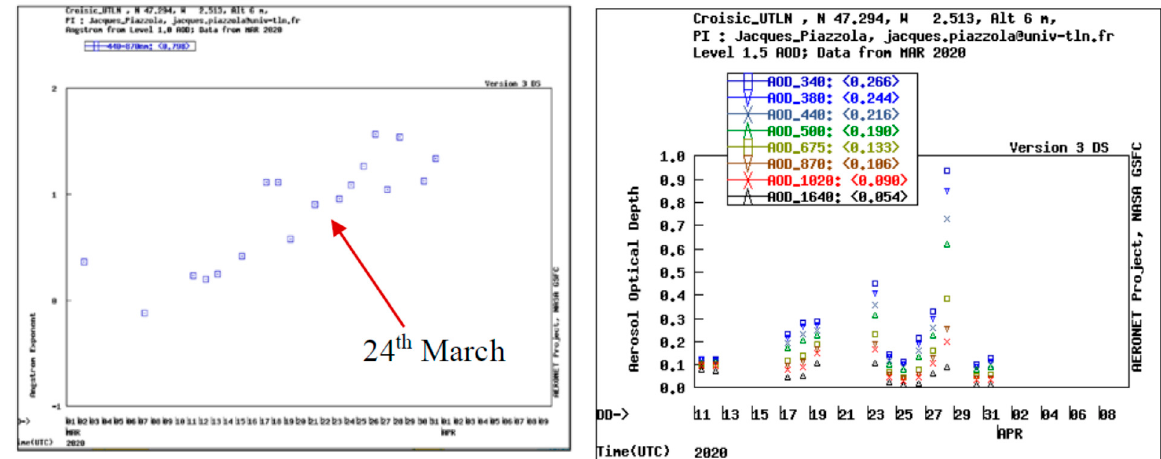
Figure 7. Temporal survey of the Angstrom coefficient ( left ) and the AOD ( right ) in Le Croisic (Nantes region) in March 2020. The arrow indicates the date of the occurrence of offshore wind conditions.